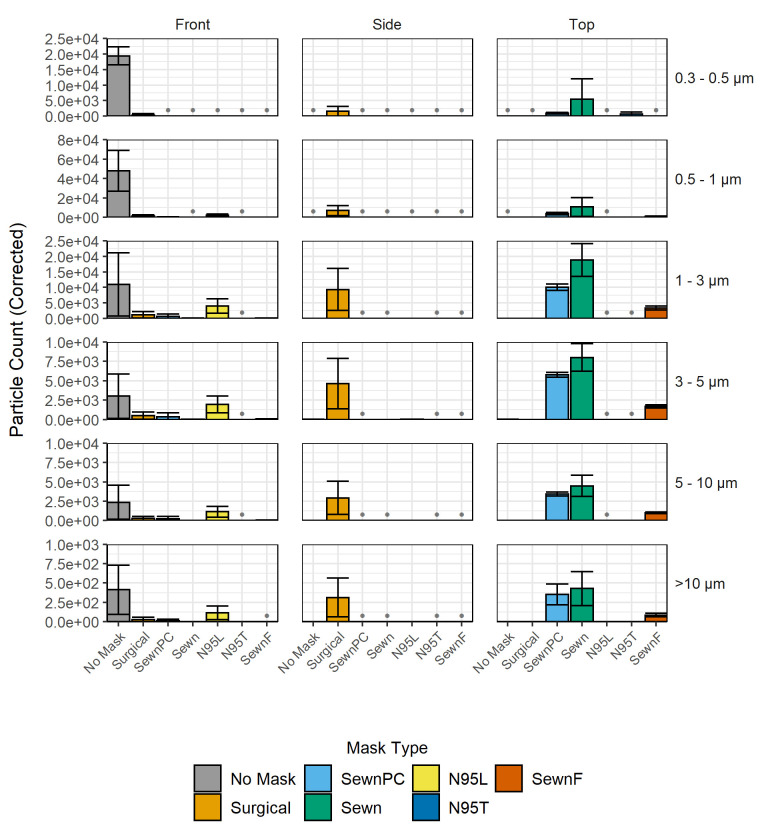
Background-corrected particle counts comparing facemask treatments within the enclosed box.Measurements shown in each row for the six particle size bins are shaded and grouped by facemask type, including No Mask, Sewn, SewnF, SewnPC, Surgical, N95L and N95T. Axes are scaled to each respective range, and gray bullet points at the baseline indicate negative corrected counts. Error bars indicate the sample standard deviation for particle counts in each of the respective particle size bins from three independent measurements. A 2-factor MANOVA and subsequent 2-factor ANOVAs were performed in addition to Tukey's Honest Significant Difference tests; p-values, relevant parameters, and analysis are shown as interactive maps and graphs included in S2 File.